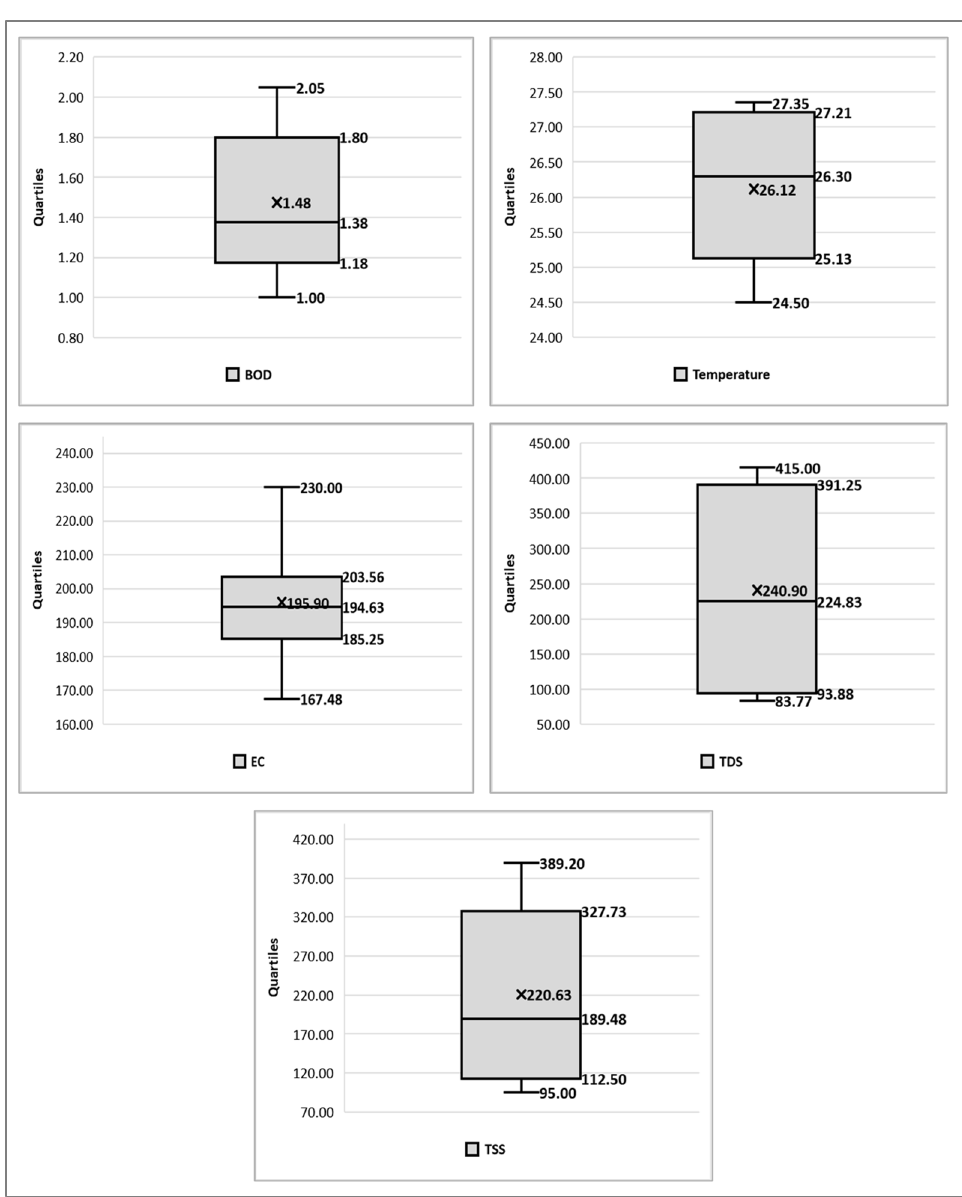
Figure 5. Box and whisker plots of dependent